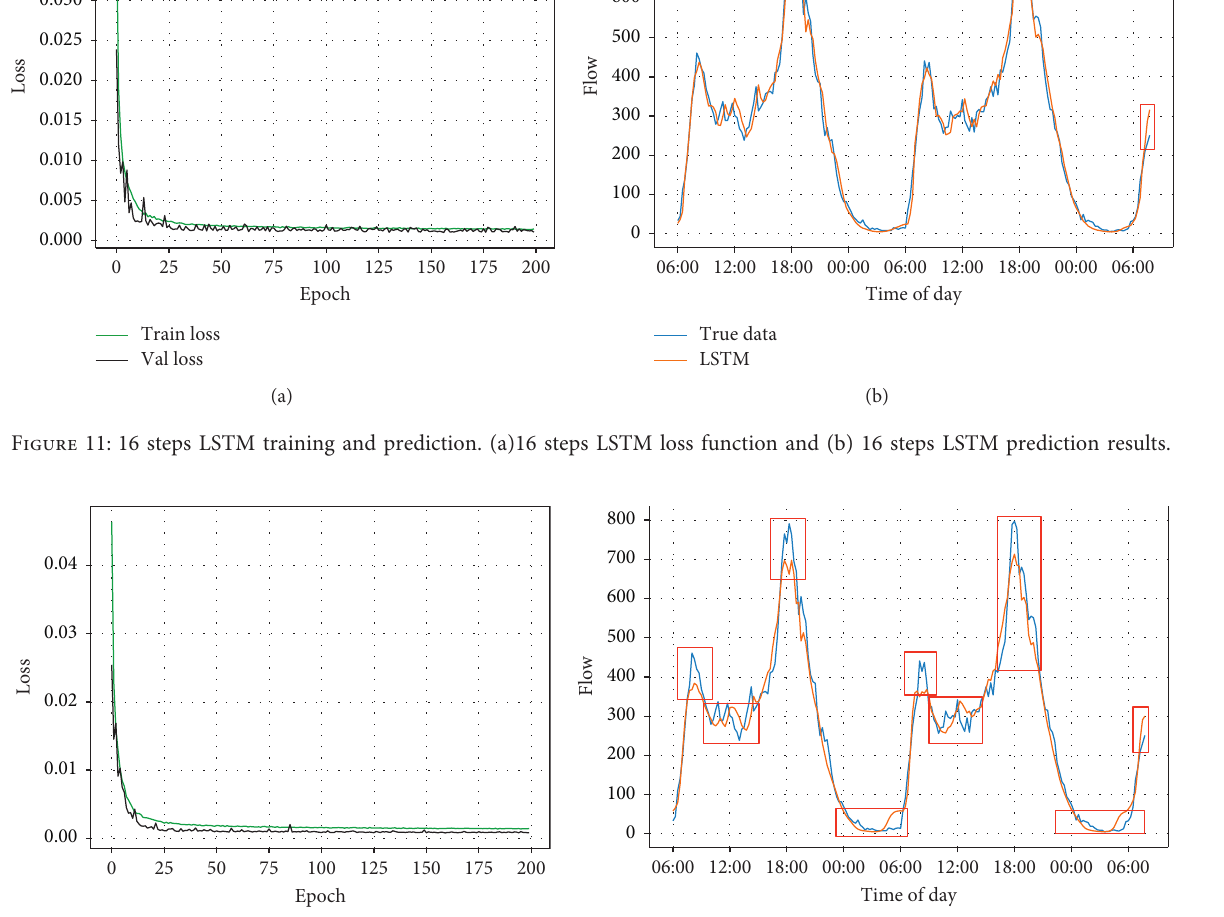
Figure 18. The input traffic data are preprocessed using MinMaxScaler normalization. According to the current short-term traffic flow data affected by the previous m data